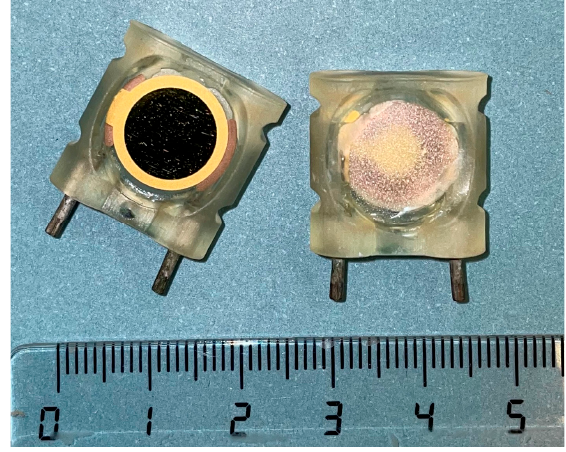
Figure 2. QCM sensor design. Left: front face. Right: back face with the rear cover.